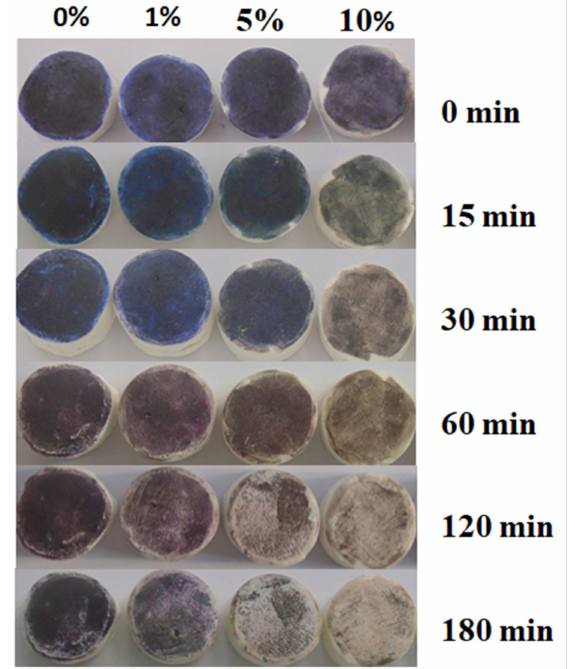
Figure 5. Photo-reduction in Rz indicator ink for 3 h reaction timeline on POP–BiF 3 (%) composites having the variation of BiF 3 0%, 1%, 5%, and 10% by wt., respectively, under the exposure of 355 nm wavelength of UV light irradiation.